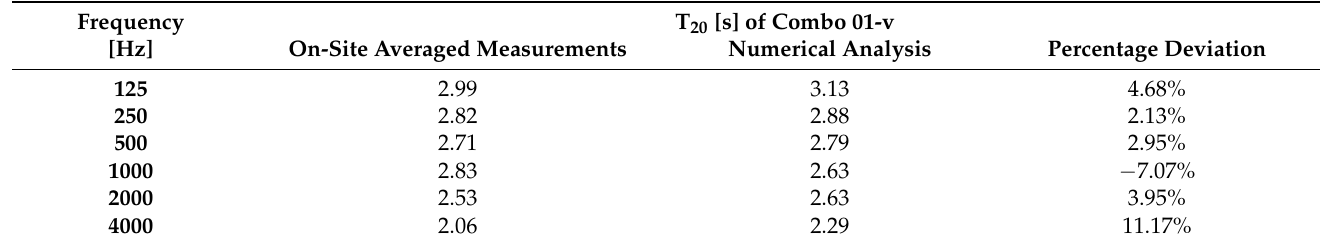
Table 13. Comparison between numerical and on-site measurements of reverberation time (T 20 ) for Combo 01-v.